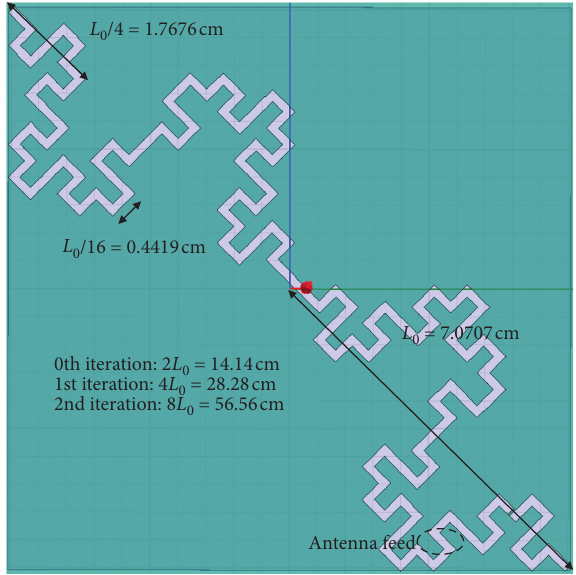
Figure 1: Schematic of the fractal slot antenna on a face of a 1U CubeSat satellite.